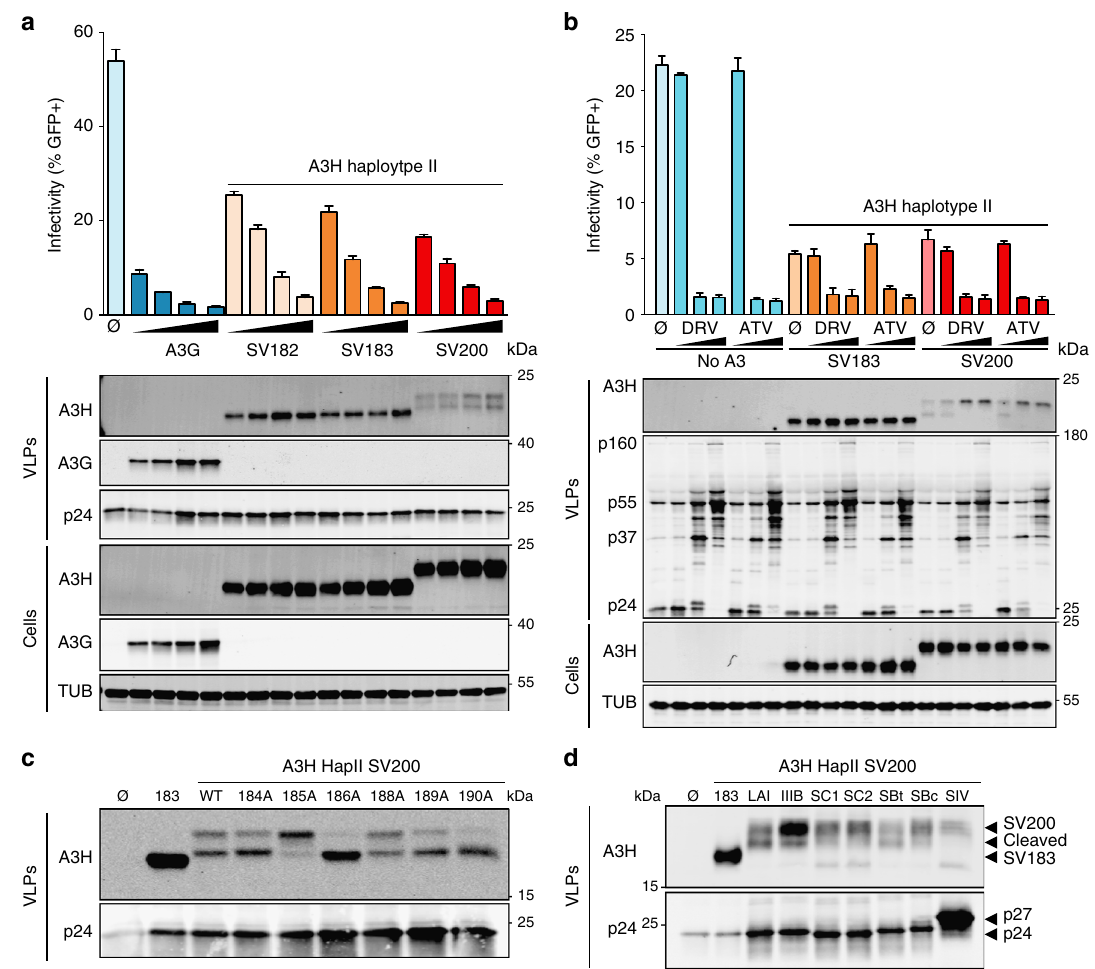
Fig. 5 HIV-1 restriction by A3H haplotype II splice variants and SV200 processing by HIV-1 protease. a Infectivity of Vif-de fi cient HIV-1 LAI produced in 293T cells in the presence of untagged A3H splice variants (50 ng, 100 ng, 200 ng, or 400ng) or V5-tagged A3G (25 ng, 50 ng, 100 ng, or 200 ng) and used to infect CEM-GFP reporter T cells ( n = 3 technical replicates; average ± SD). Immunoblots are shown below for producer cells and virus-like particles (VLPs). b Infectivity of Vif-de fi cient HIV-1 LAI produced in 293T cells in the presence of a control vector (no A3) or the indicated untagged A3H splice variants (200 ng). HIV-1 protease inhibitors (0.3 nM, 3 nM, or 300 nM) darunavir (DRV) or atazanavir (AZV) were added 6 h post-transfection or 42 h before virus particle collection, virus infectivity assays using CEM-GFP reporter cells, and VLP and cell lysate immunoblotting as in ( a ). c Immunoblots of A3H haplotype II SV200 and mutant derivatives in VLPs, following production in 293T cells. Gag (p24) is shown as a loading control. d Immunoblots of A3H haplotype II SV183 and SV200 in VLPs from the indicated proviral plasmids, following production in 293T cells. Gag (p24 for HIV-1 isolates and